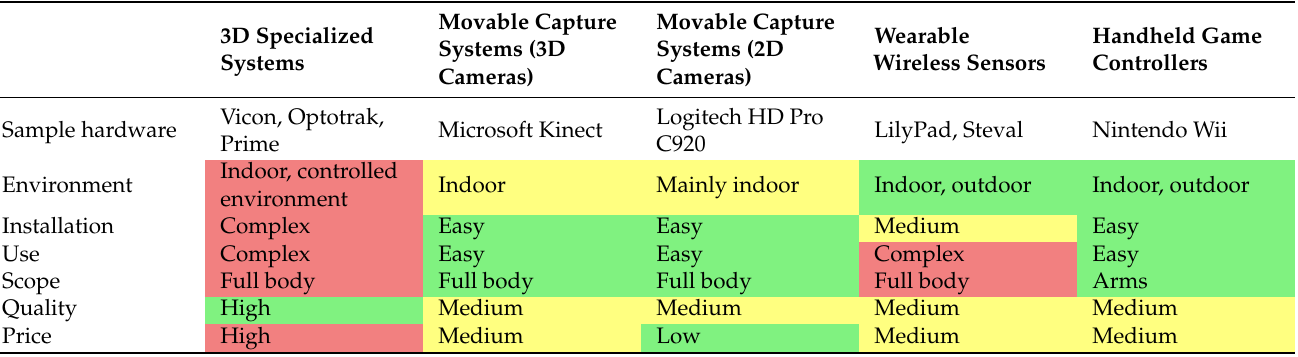
Table 1. Summary table: pros and cons of movement capture systems. Background cell color